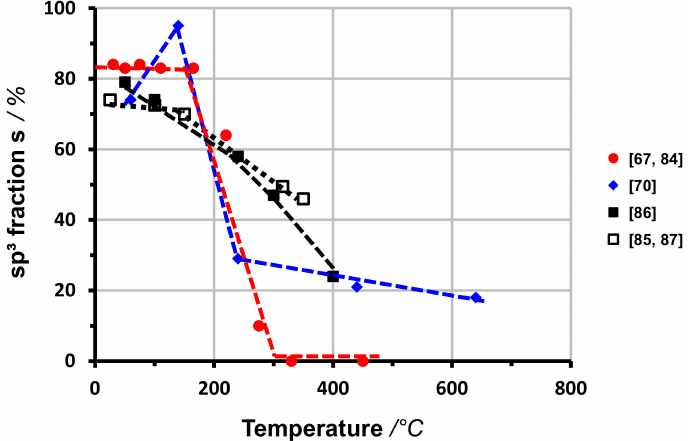
Figure 19. Dependence of the sp 3 fraction on the substrate temperature for carbon films prepared by filtered arc deposition with ion energies of 60 eV [85,87], of 80 eV [86], of 90 eV [67,84] and of 100 eV